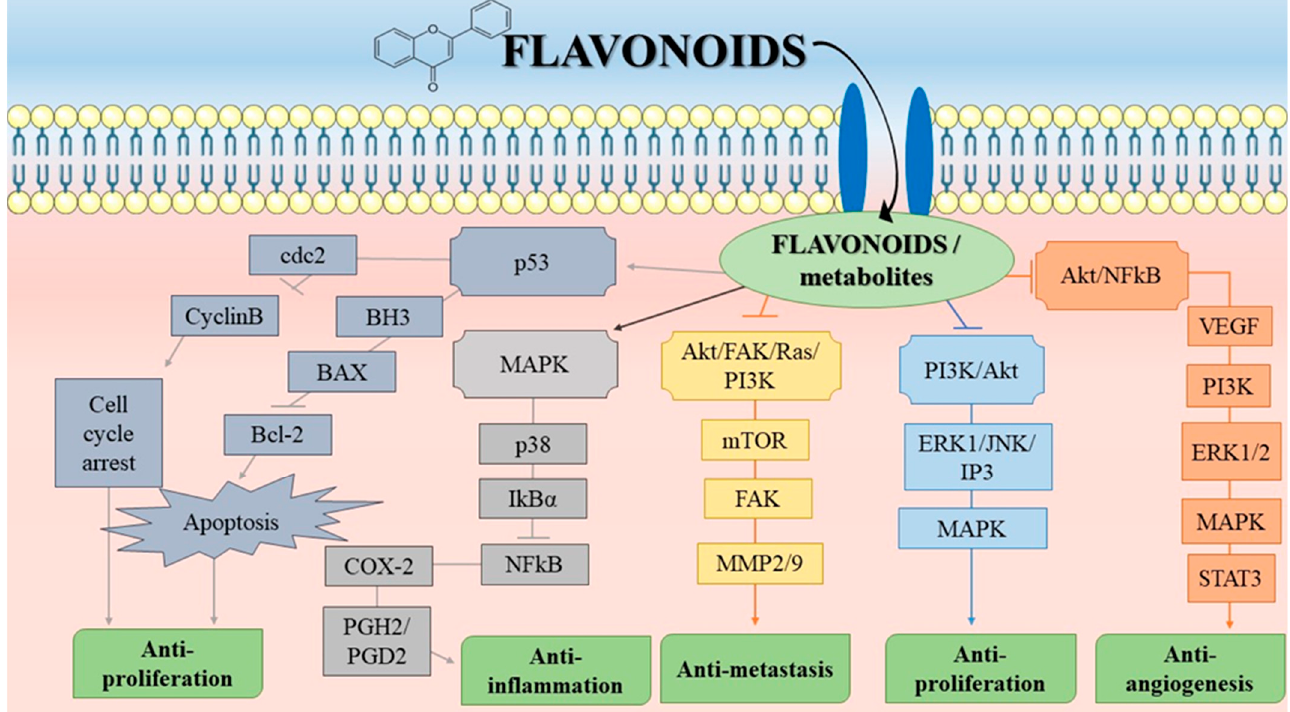
Figure 5. Schematic overview of the most common signalling pathways through which flavonoids act on malignant processes in the cells. The final outcomes on the molecular level of cell organization include anti-proliferation, anti-inflammation, anti-metastasis and anti-angiogenesis effects. By acting upon p53 (cellular tumour antigen) molecule, which further acts on inhibiting cdc2 (Cyclin-dependent kinase) and CyclinB and therefore causes cell cycle arrest with anti-proliferation as an end result. Furthermore, p53 has an impact on blockading BH3 (borane trihydridoboron), BAX (BCL2 Associated X, Apoptosis Regulator) and Bcl-2 (B-cell lymphoma 2) molecules which leads to apoptosis and also causes inhibition of proliferation. Another significant molecule is MAPK (Mitogen-activated protein kinases), which further blocks the p38 (tumour suppressor), IKBalpha (nuclear factor of kappa light polypeptide gene enhancer in B-cells inhibitor, alpha), NFkappaB (Nuclear factor kappa-light-chain-enhancer of activated B cells), COX2 (Cyclooxygenase) and PGH2/PGD2 (Prostaglandin H2/D2) pathway, with a final result of inhibition of inflammation. Another pathway on which flavonoids act upon is Akt (Protein kinase B, PKB)/FAK (Focal adhesion kinase)/Ras (Rat sarcoma virus protein)/PI3K (Phosphoinositide 3-kinases) pathway, through mTOR (mammalian target of rapamycin), FAK and MMP2/9 (matrix metallopeptidase 2/9) molecules. Blockade of Akt/FAK/Ras/PI3K pathway causes inhibition of metastasis. PI3K/Akt molecules are also significant in anti-proliferation module of flavonoid action, through another group of molecules, MAPK and ERK1 (Extracellular signal-regulated kinases)/JNK (c-Jun N-terminal kinases)/IP3 (Inositol trisphosphate). Finally, anti-angiogenesis properties that arise from flavonoid action is through Akt/NFkappaB pathway, which includes VEGF (Vascular endothelial growth factor), PI3K, ERK1/2, MAPK and STAT3 (Signal transducer and activator of transcription 3) molecules.